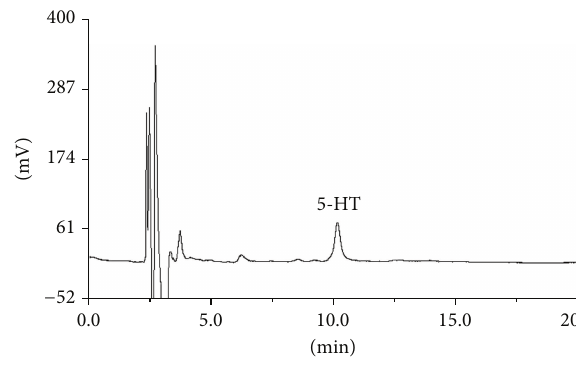
Figure 4: The chromatogram of 5-HT.